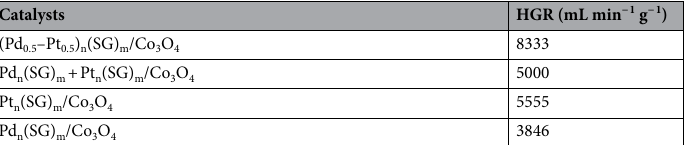
Table 3. Hydrogen generation rate (HGR) for NaBH 4 hydrolysis reaction over different catalysts. Catalytic test: 1 g of NaBH 4 in 100 H 2 O; Catalyst, 5 mg; at 25 °C.